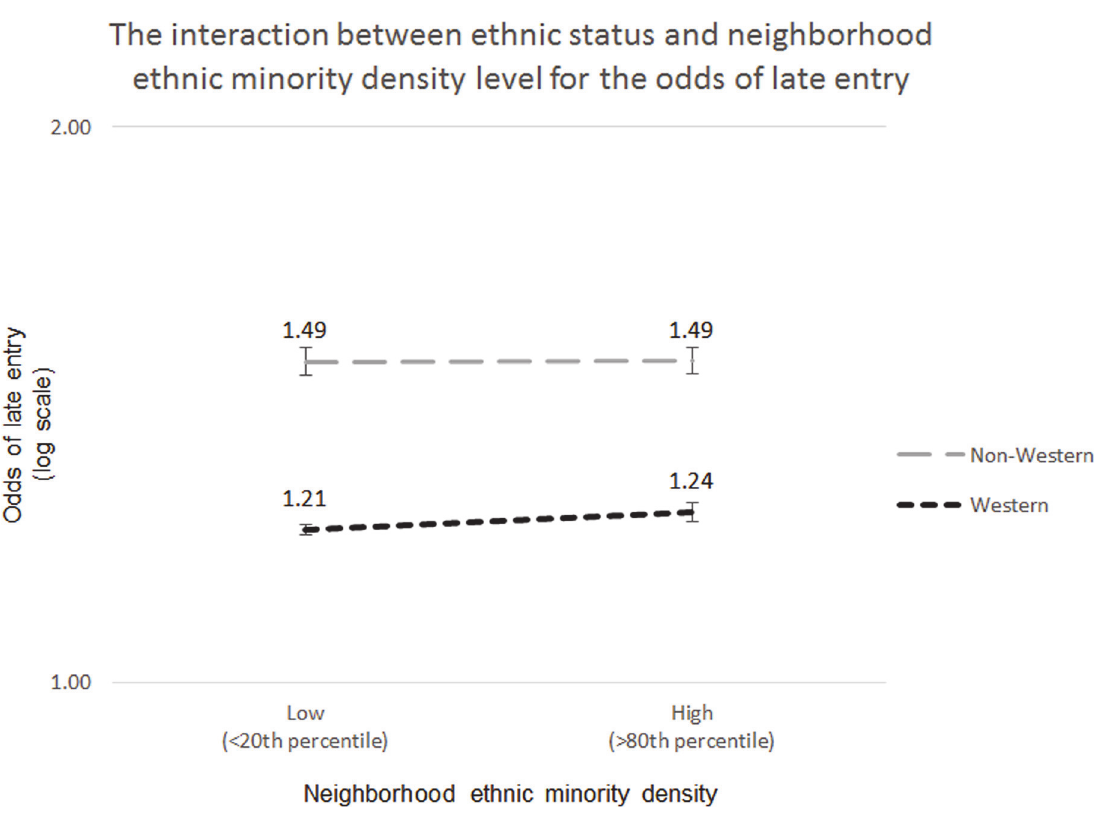
Fig 2. The interaction between ethnic status and neighborhood ethnic minority density level for the odds of late entry. This Fig. demonstrates that higher proportions of ethnic minority density in a neighborhood have a less detrimental effect on non-Western women than on Western women in terms of their risk of late entry into care. Low ethnic density: 20 percent neighborhoods with the lowest proportions of non-Western inhabitants; high ethnic density: 20 percent neighborhoods with the highest proportions of non-Western